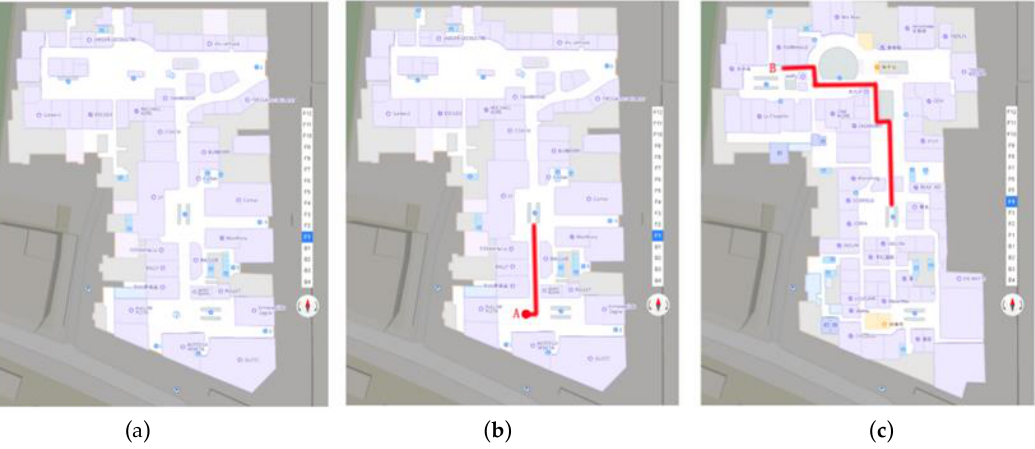
Figure 2. Indoor map for wayfinding: ( a ) Indoor map of the 1st floor for Task 1, Routes of 1st floor ( b ) and 4th floor ( c ) for Task 2 and Task 3.